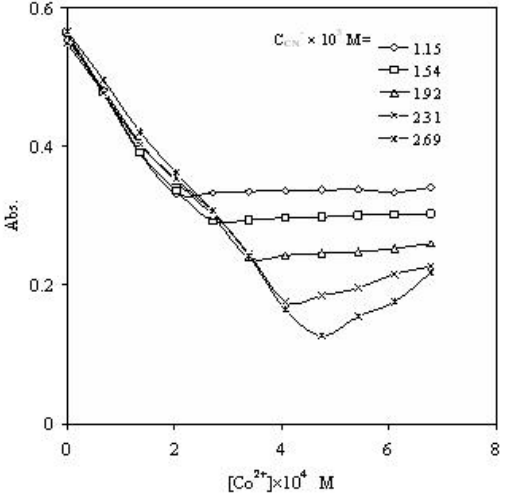
Fig. 7 Titration of CN − (1 . 15 − 2 . 69) × 10 − 3 M with Co 2+ solution, citrate 0.004 M, and pH